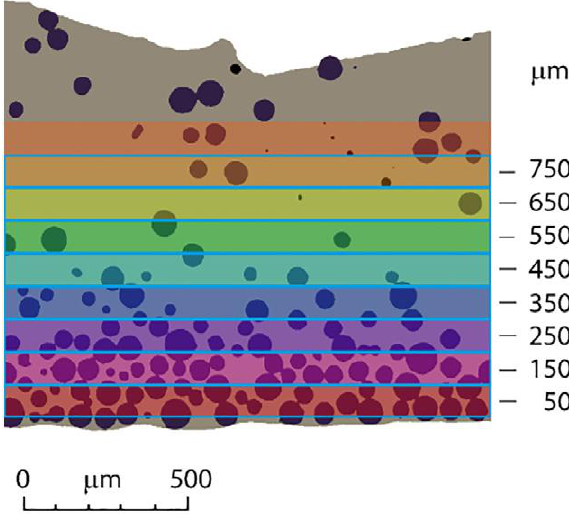
Figure 3: The distribution of WC particles in Ni based coatings